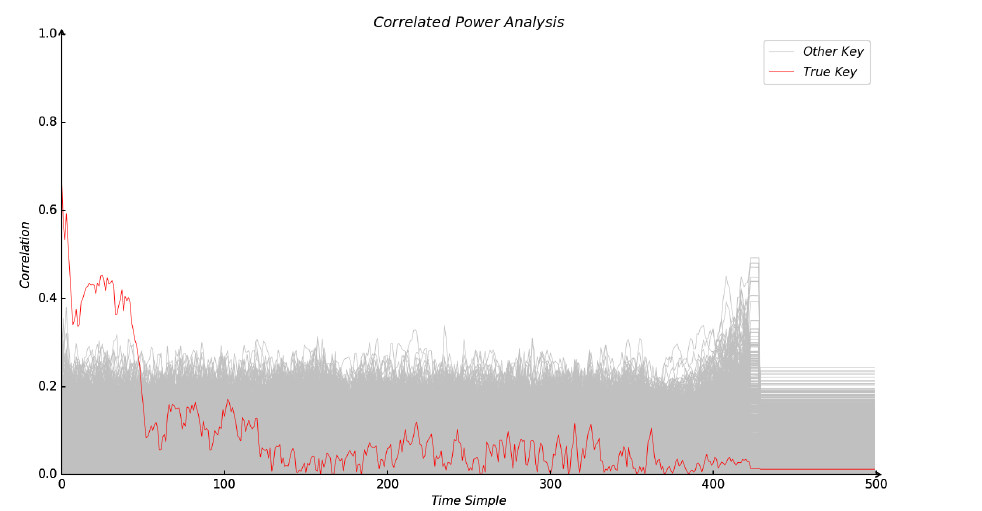
Figure 13. Group B: CPA result of experiment with 1 round calculated by software.